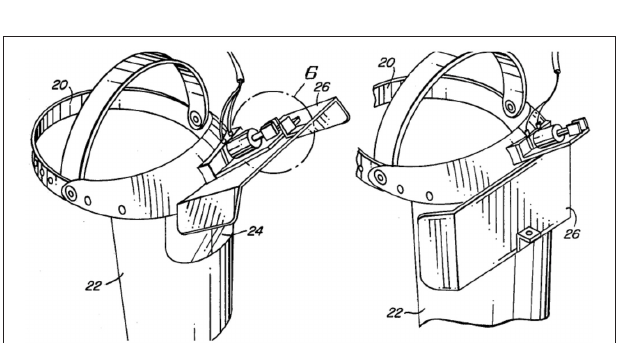
FIGURE 5 | Occlusion Glasses (courtesy Translucent Technologies).